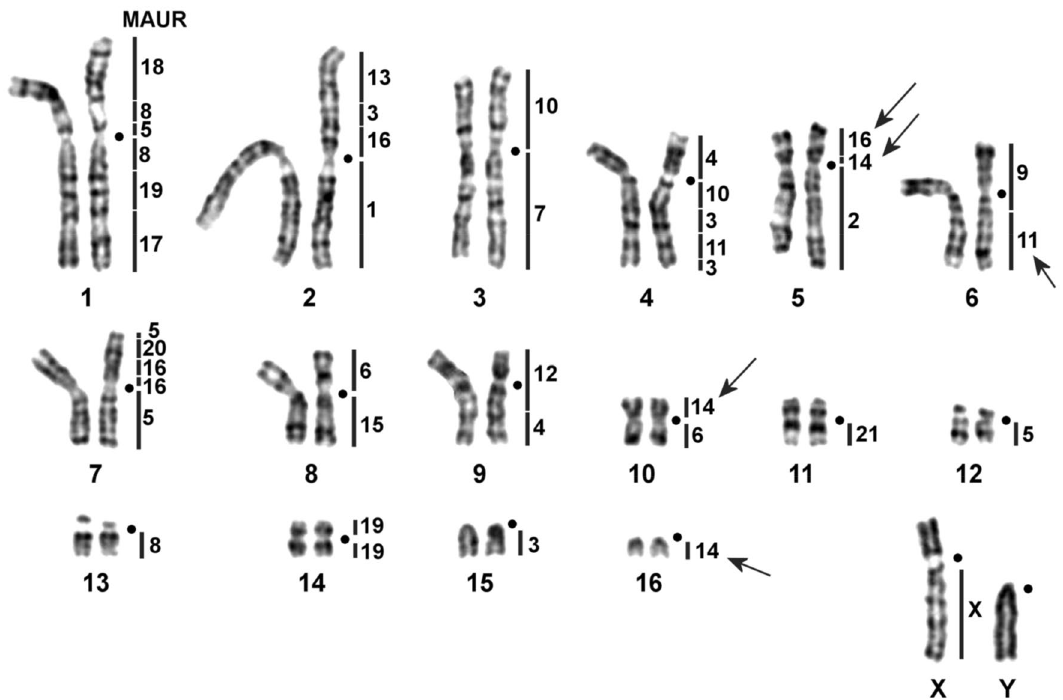
Figure 4. The male karyotype of P. roborovskii with corrected localization of M. auratus probes (black lines) on G-banded chromosomes. Centromere positions are marked by black points. Black arrows indicate the regions in which the localization of probes changed relative to those published previously 29